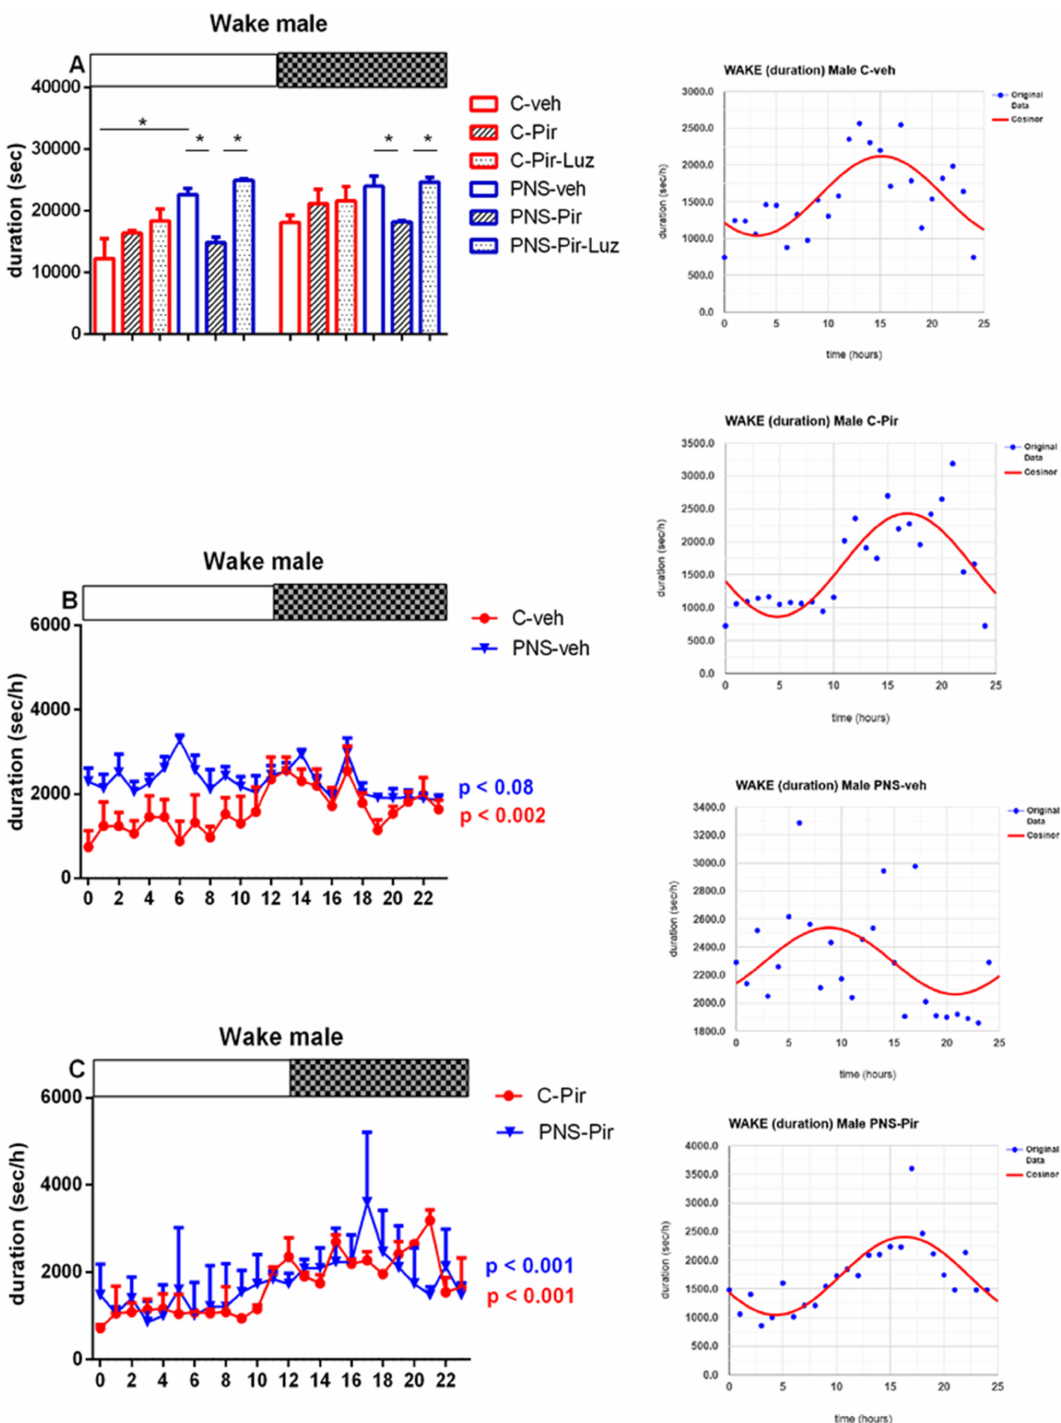
Figure 4. Diurnal rhythm of Wake (duration, sec/h) in male rats during the Light and the Dark phase, indicated by open and black rectangles above the figure, over a 24-h recording for C-veh, C-Pir, C-Pir-Luz, PNS-veh, PNS-Pir and PNS-Pir-Luz group ( A ). Circadian distribution of Wake events (duration, sec/h) for C-veh and PNS-veh groups ( B ) and C-Pir and PNS-Pir groups ( C ) over a 24-h recording. Original and cosinor data are shown in the inset on the right. * p < 0.05 vs. C-veh, PNS-veh or PNS-Pir group, respectively. Details as in Figure